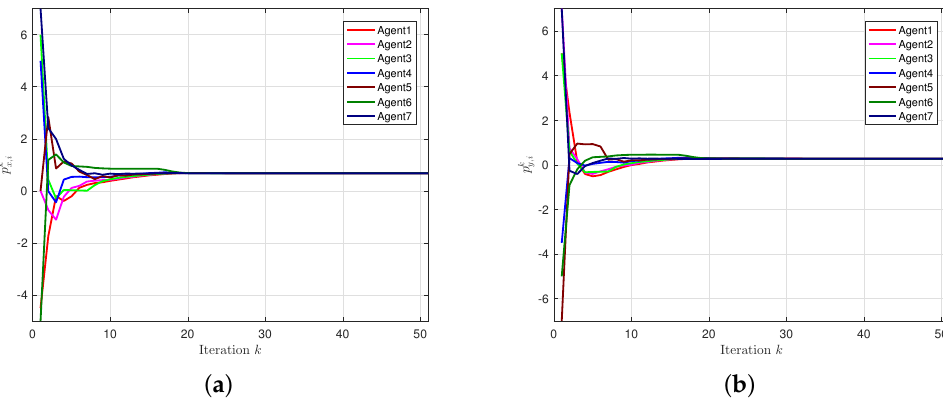
Figure 4. Evaluations of positions. ( a ) Evaluations of p k